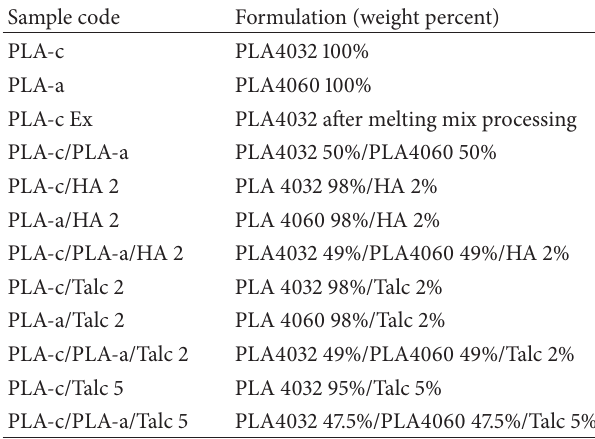
Table 1: Sample list used for this